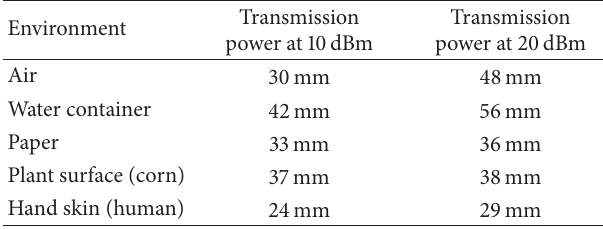
Table 1: Comparison of near-field